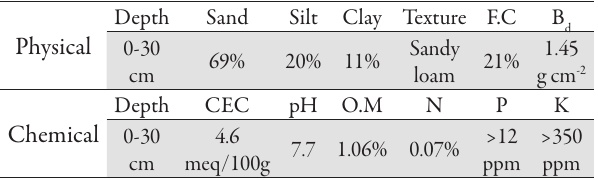
Tab. 1. Physical and chemical soil properties of